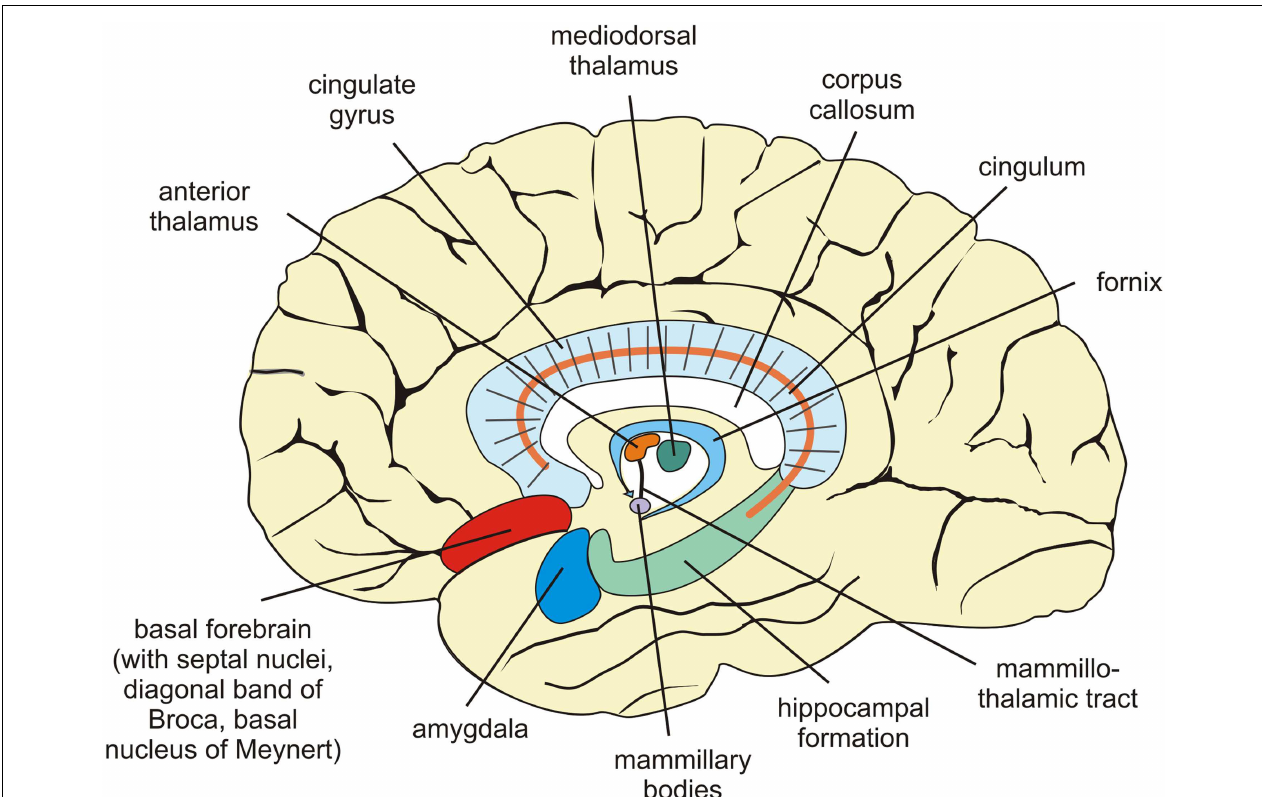
FIGURE 2 | Sagittal view of the human brain showing structures centrally implicated in information processing, especially with respect to the transfer of newly acquired memories for long-term storage.